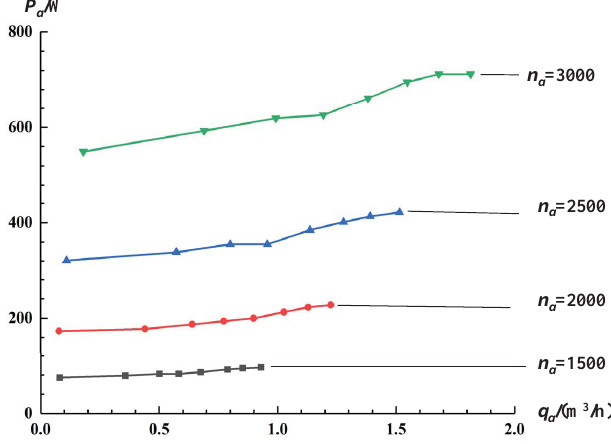
Figure 9. Power characteristics of the